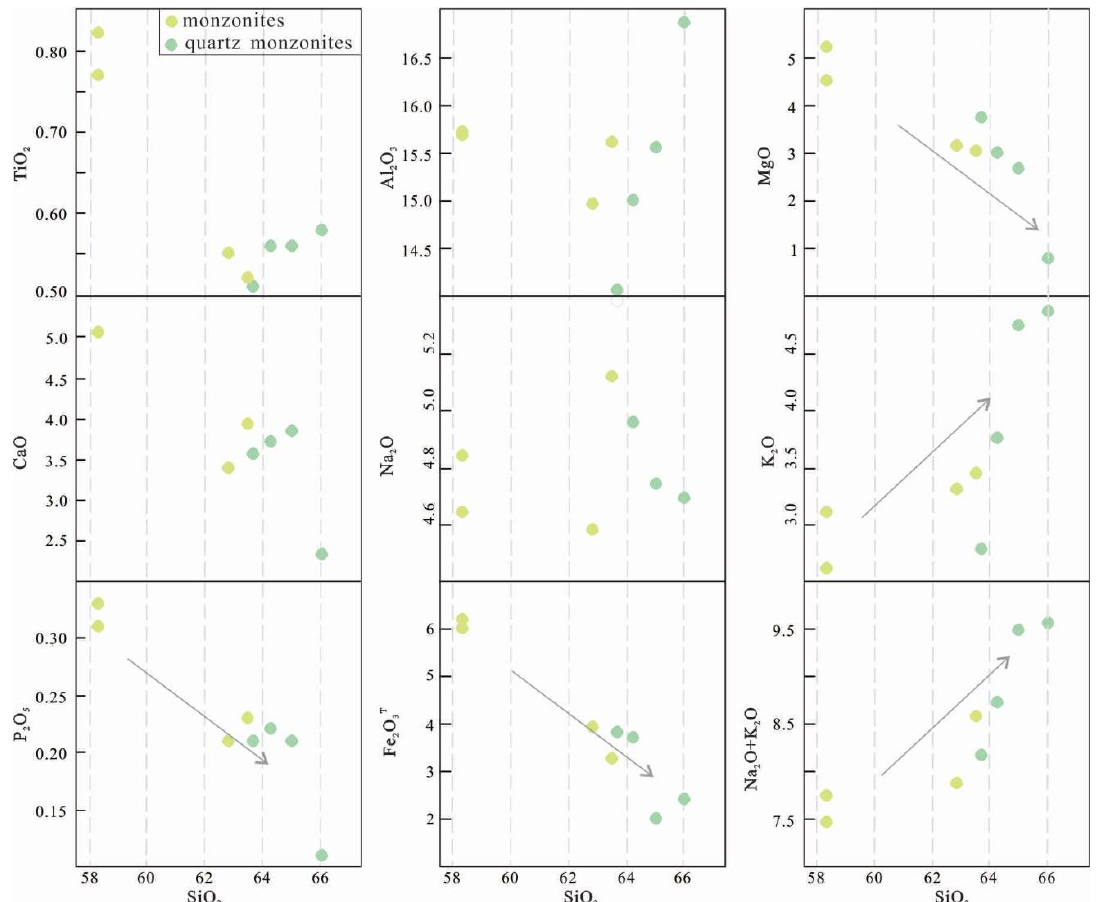
Figure 6. Harker diagram of quartz monzonites and monzonites; the data of monzonites are from reference [11].